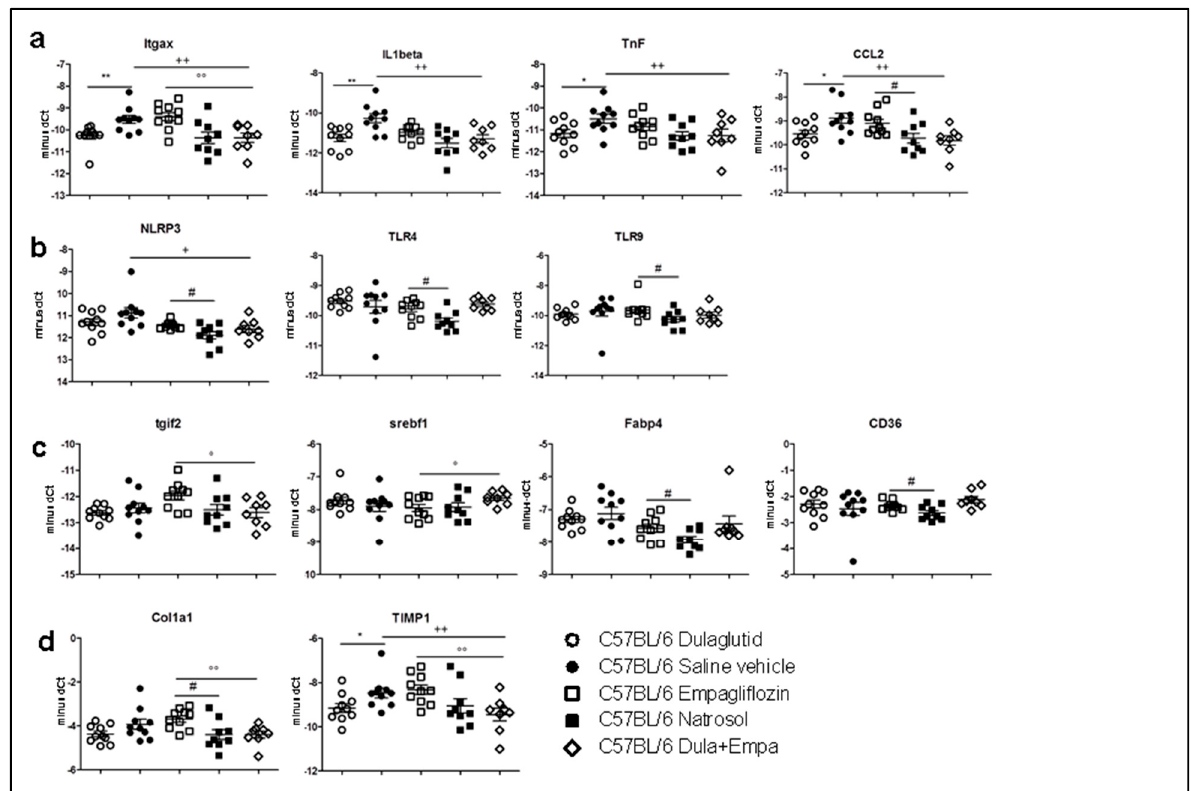
Figure 4. Gene expression. Normalized gene expression representing pathways of inflammation, inflammasome, fibrosis and lipid metabolism. Genes that were expressed significantly differently upon PCA were exemplarily chosen to visualize changes in the pathways of ( a ) inflammation, ( b ) inflammasome, ( c ) lipid metabolism and ( d ) fibrosis. Unpaired t -test with Welsh-correction was used for comparison between treatment and control group. One-way ANOVA with Tukey’s multicomparison test was used for differences between treatment groups. C57BL/6 Dulaglutide: n = 10, C57BL/6 Saline vehicle: n = 10, C57BL/6 Empagliflozin: n = 10, C57BL/6 Natrosol: n = 10; C57BL/6 Dula + Empa: n = 9. * p < 0.05; ** p < 0.01; *** p < 0.001 was used for comparison of Dulaglutide vs. Saline vehicle. # p < 0.05; ## p < 0.01; ### p < 0.001 was used for comparison of Empagliflozin vs. Natrosol. + p < 0.05; ++ p < 0.01; +++ p < 0.001 was used for comparison of Dula + Empa vs. Saline vehicle. ° p < 0.05; °° p < 0.01; °°° p < 0.001 was used for the comparison of Dula + Empa vs. Empagliflozin.